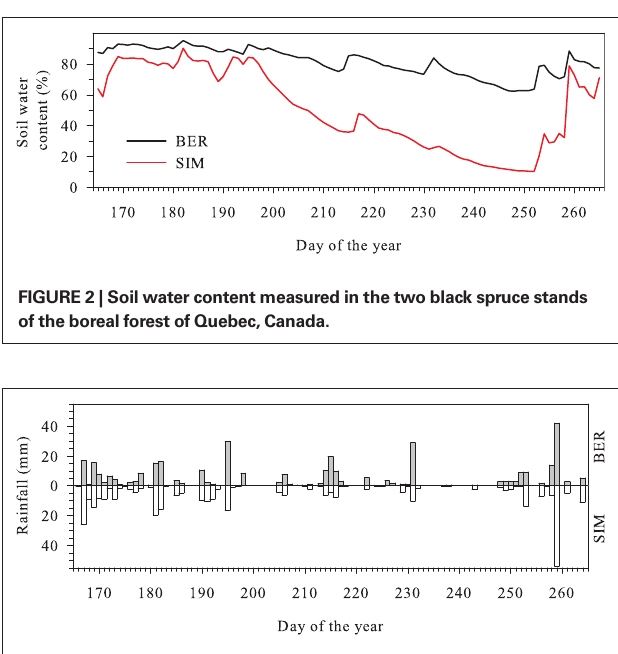
Figure 3 | Daily rainfall measured in the two black spruce stands of the boreal forest of Quebec,